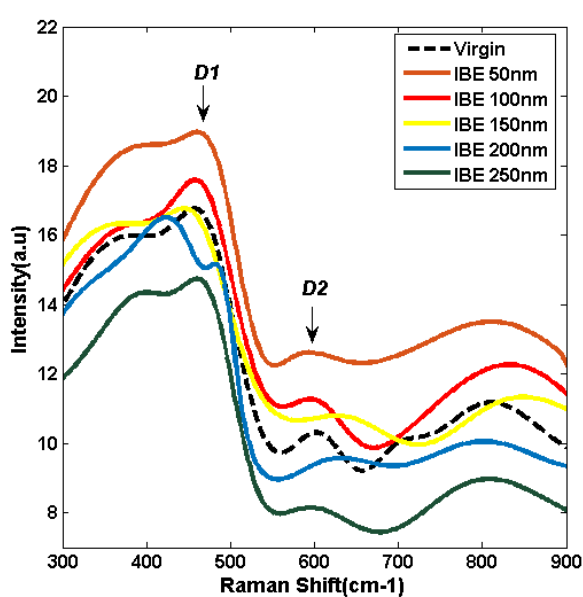
Figure 4. Raman spectra analysis with various IBE depths.